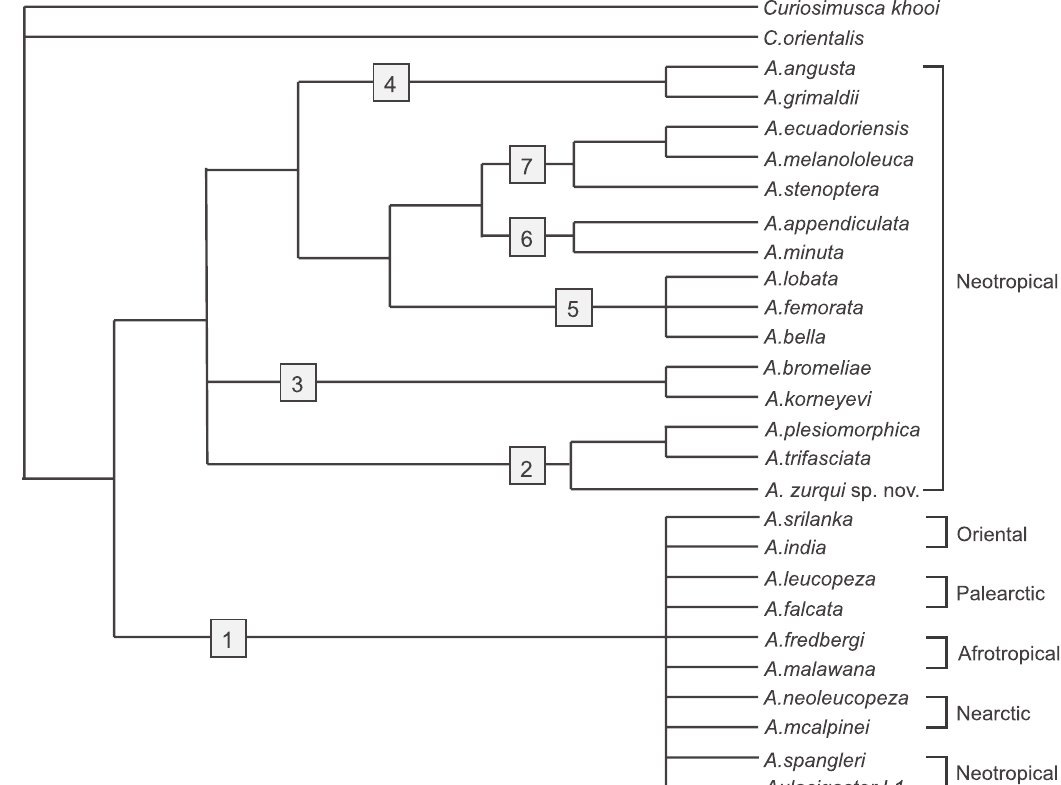
Figure 1. Strict consensus cladogram obtained from 17 optimum trees, summarizing a cladistics analysis of Aulacigaster . The optimum trees were obtained with a branch-and-bound search, characters unordered and equally weighted, and have 41 steps, consistency-index (CI) 0.78 and retention index (RI) 0.91. The number on the nodes indicate the species-groups as follows: 1. The leucopeza group; 2. The plesi- omorphica group; 3. The bromeliae group; 4. The grimaldii group; 5. The femorata group; 6. The minuta group; 7. The ecuadoriensis